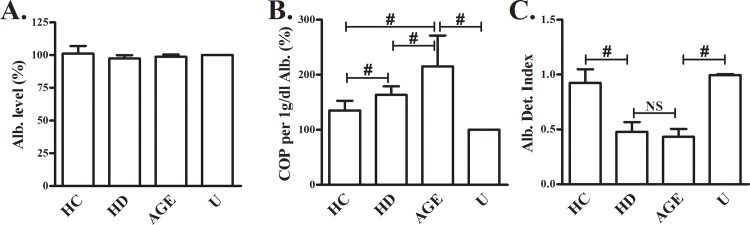
COP values of purified albumin from HC and HD sera.Albumin was purified from HD and HC sera, diluted to give equal concentrations and used for COP measurements after addition (of equal volume of each sample) to a normal (HC) sample with known albumin level and index (a single HC serum was used in each experiment). Albumin quantification by BCG (A), COP values (calculated per 1g/dl of the purified albumin and given as % of unmodified HSA) (B), and the albumin detection index values (C) are given as mean+SD. Glycoxidized (AGE) and unmodified (U) HSA that were treated identically, served as positive and negative controls, respectively. # indicates a significant p value (p<0.05). N = 5.